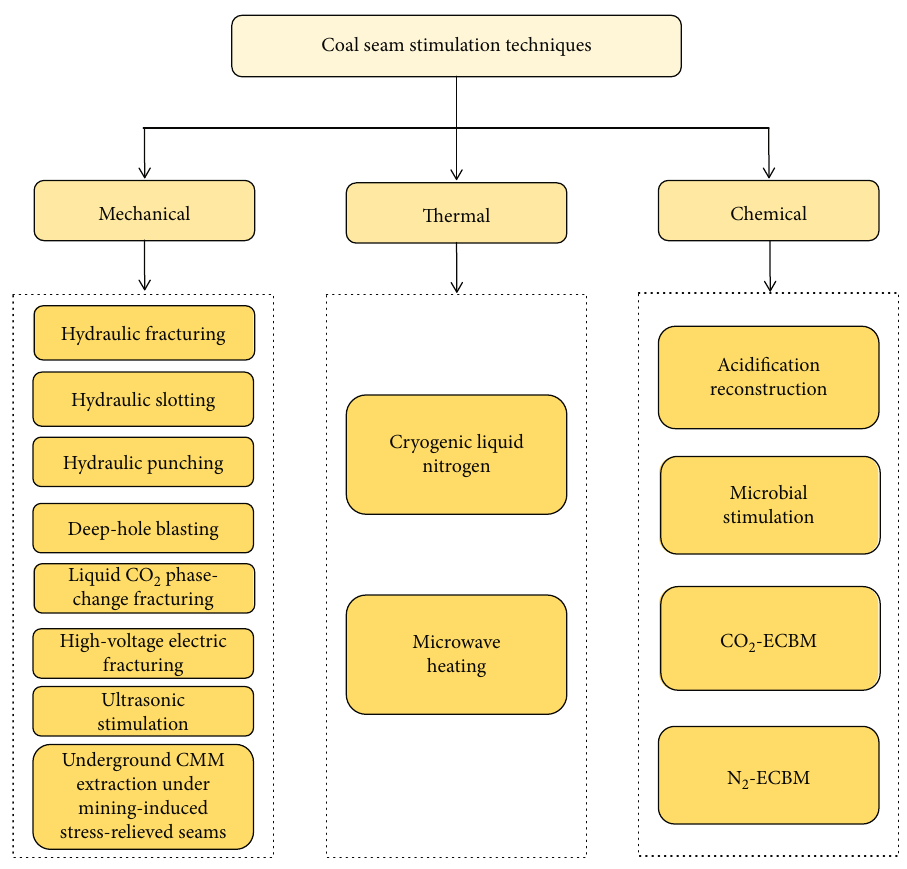
Figure 4: Classi fi cation of coal seam stimulation techniques.